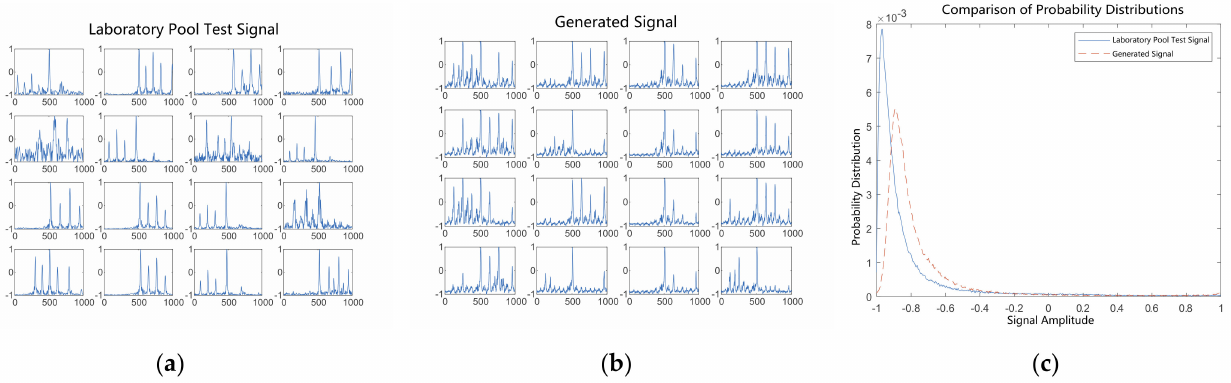
Figure 11. Comparison of generated signals with pool test signals after 100 epochs of training.